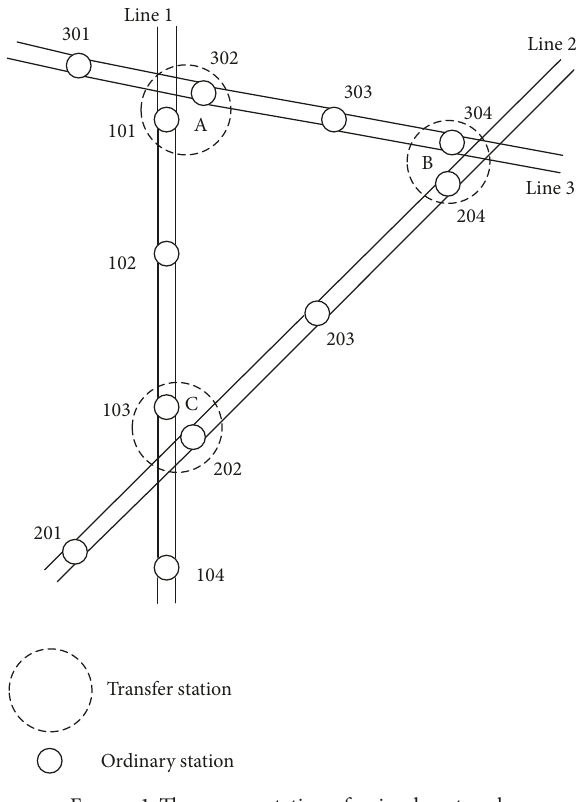
Figure 1: The representation of a simple